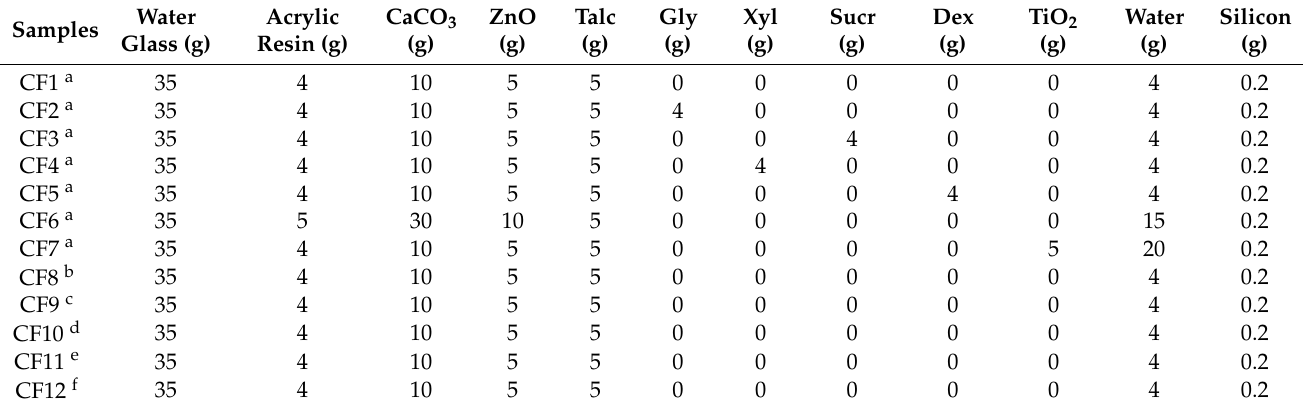
Table 1. Recipes for the preparation of different coating